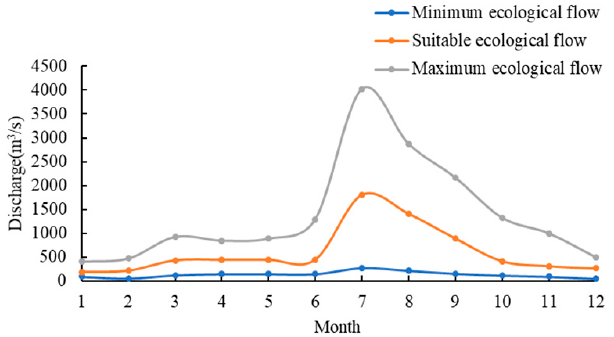
Figure 7. Results of minimum, suitable, and maximum ecological flows for each month.